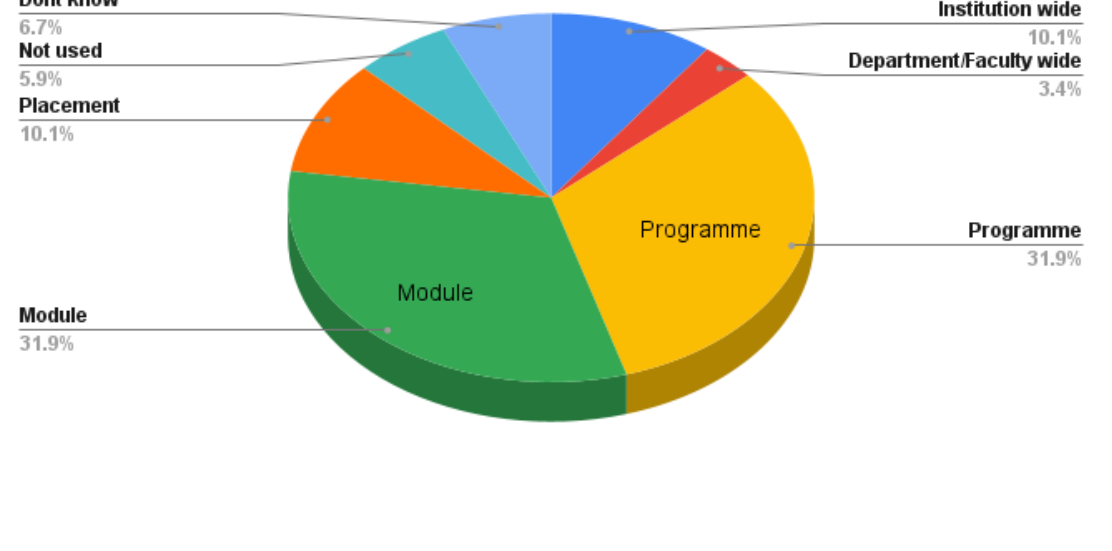
Figure 2. Institutional engagement with eportfolio